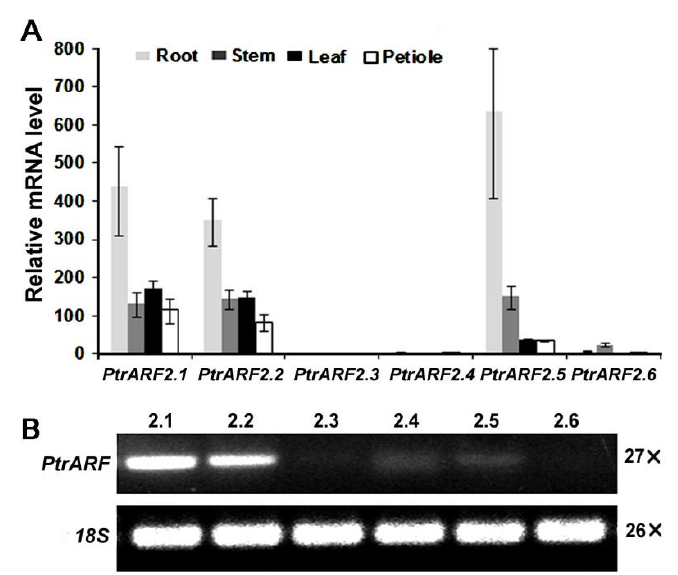
Figure 2. Expression patterns of PtrARF2 genes in poplars. ( A ) Quantitative reverse transcription PCR analysis of all the PtrARF2 genes in different organs and tissues of poplars. Transcript level of PtrARF2.4 in different tissues was used as reference (relative mRNA level 1). Error bars mean ±SD of three biological replicates. ( B ) Semi-quantitative PCR analysis of PtrARF2 genes in the leaf tissue. The poplar 18S rRNA was used as an internal control.